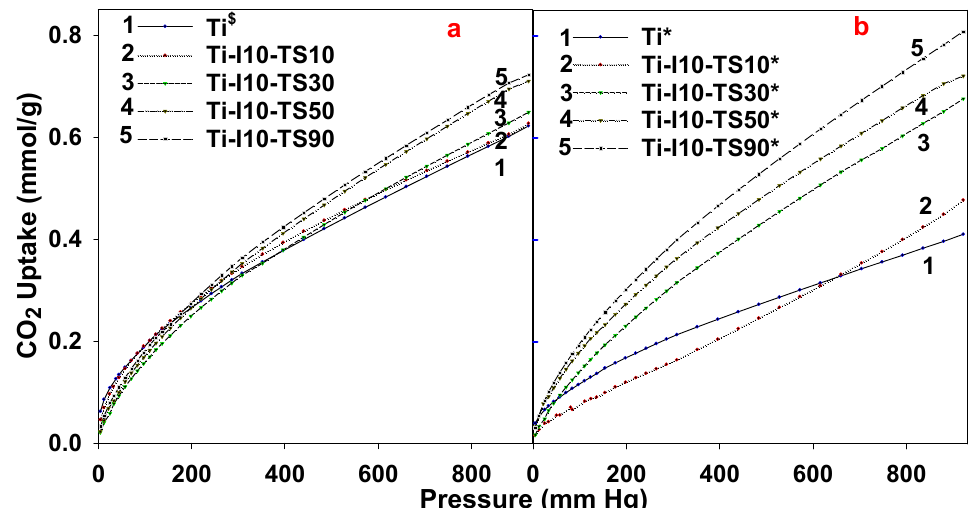
Figure 9. CO 2 sorption isotherms at 25 °C measured on Ti-Ix (x = 20, 100) and Ti-I10-TSx (x = 5, 10, 50).